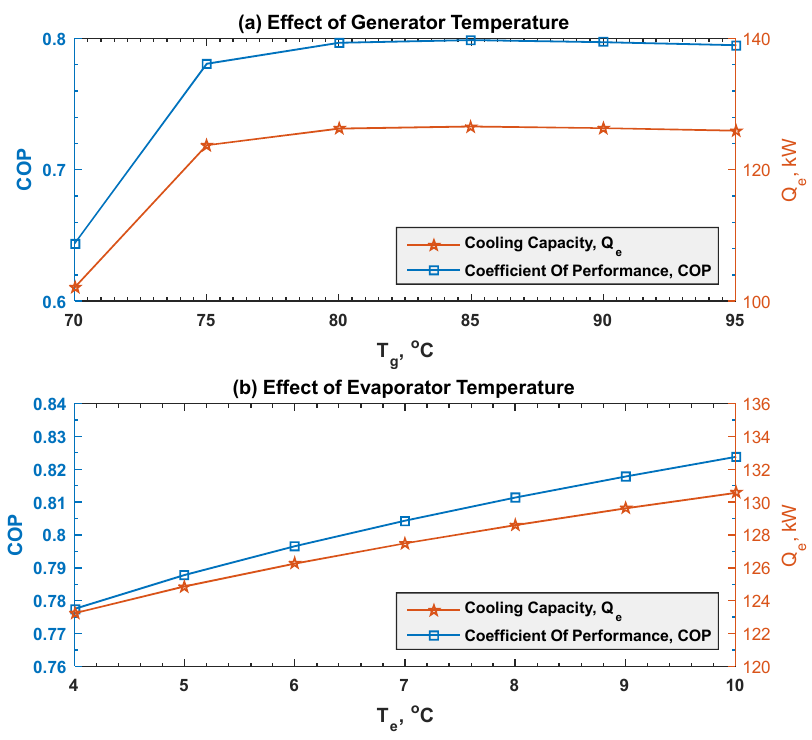
Figure 8. Generator and evaporator temperatures effects on chiller performance.